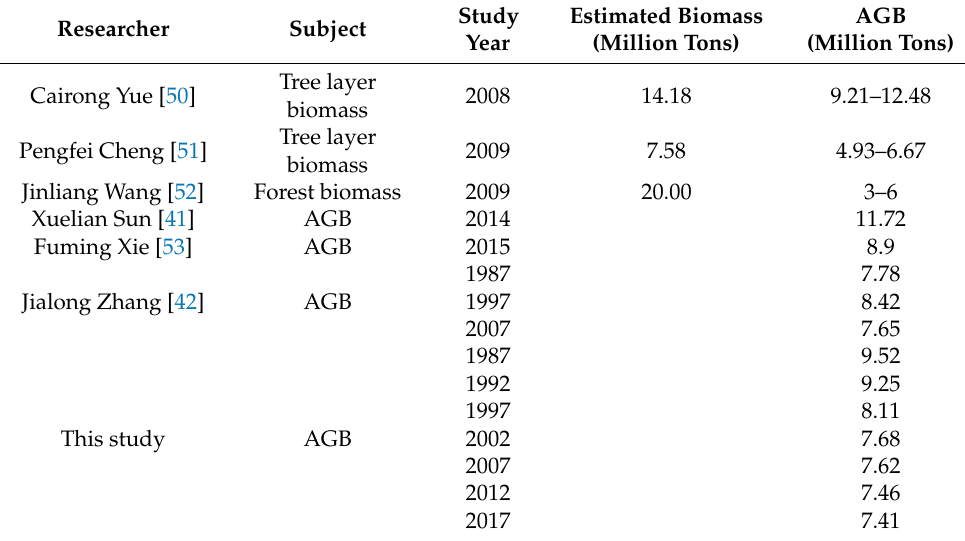
Table 5. Summary of results by different